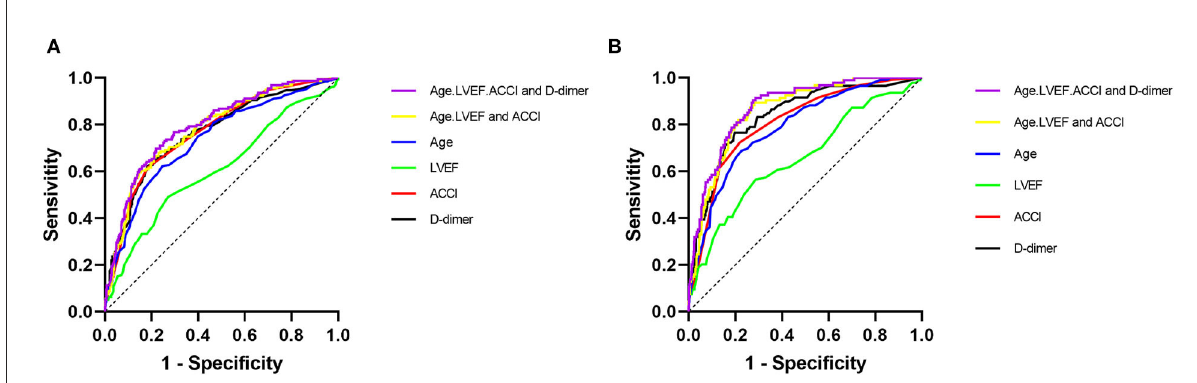
FIGURE3 The receiver operating characteristic (ROC) curve. (A ) MACEs, (B) All-cause death.